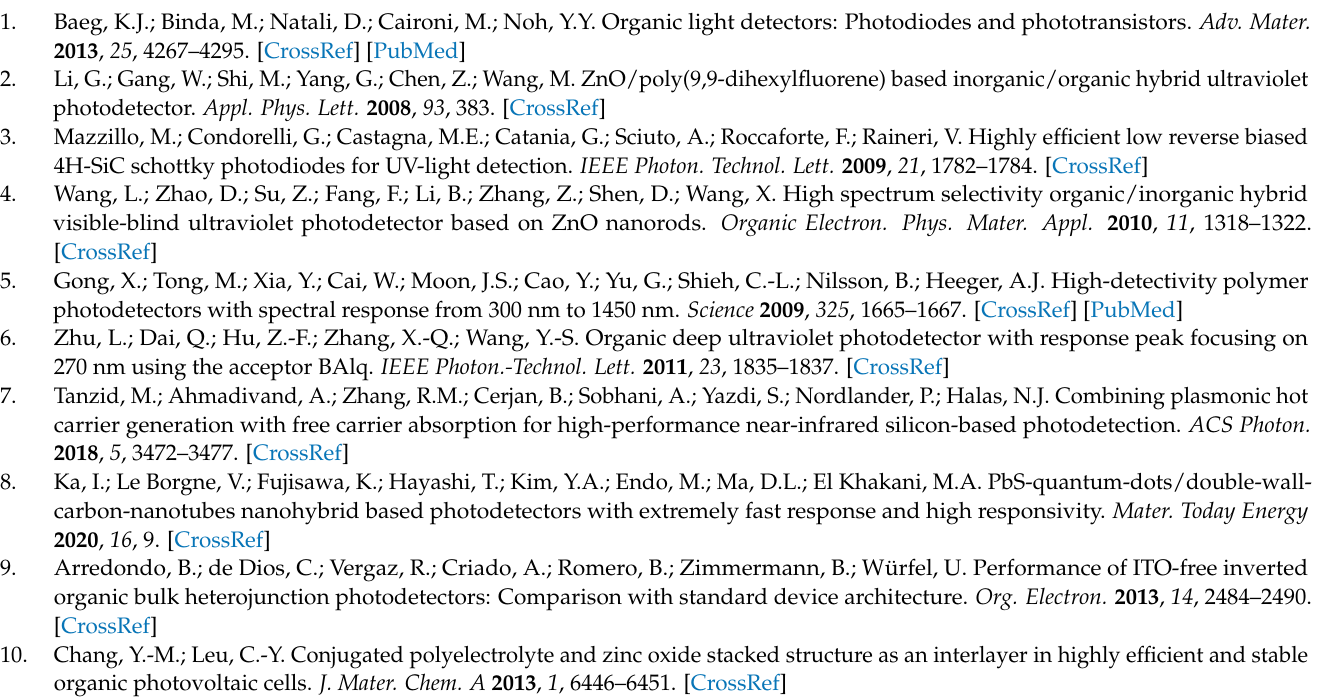
Figure S3. Ultraviolet photoemission spectra (He I) of